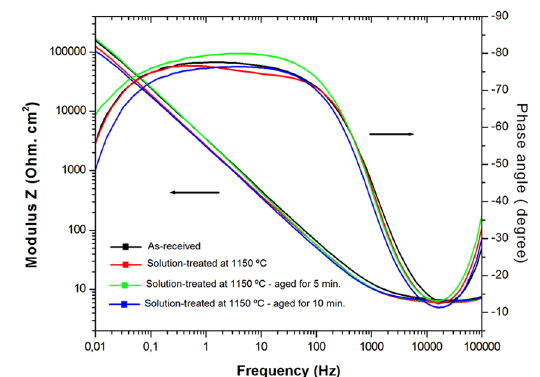
Figure 5. Bode phase angle diagrams of UNS S32520 super duplex stainless steel in the conditions: as-received, solution-treated at 1150ºC, solution-treated at 1150ºC and aged at 850ºC for 5 and 10 minutes in a 3.5% NaCl solution at room